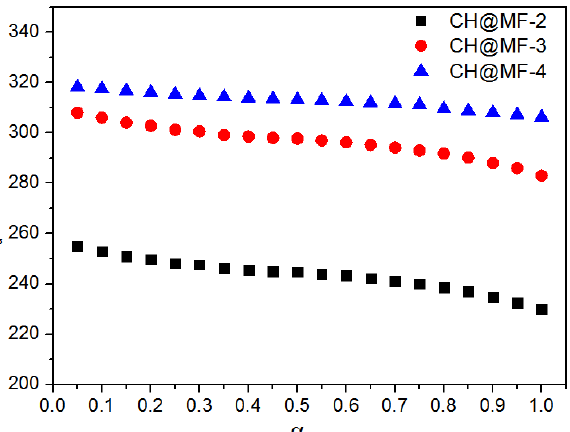
Figure 8. DSC curves of the CL-20/HMX cocrystal and CH@MF composites with a heating rate of 10